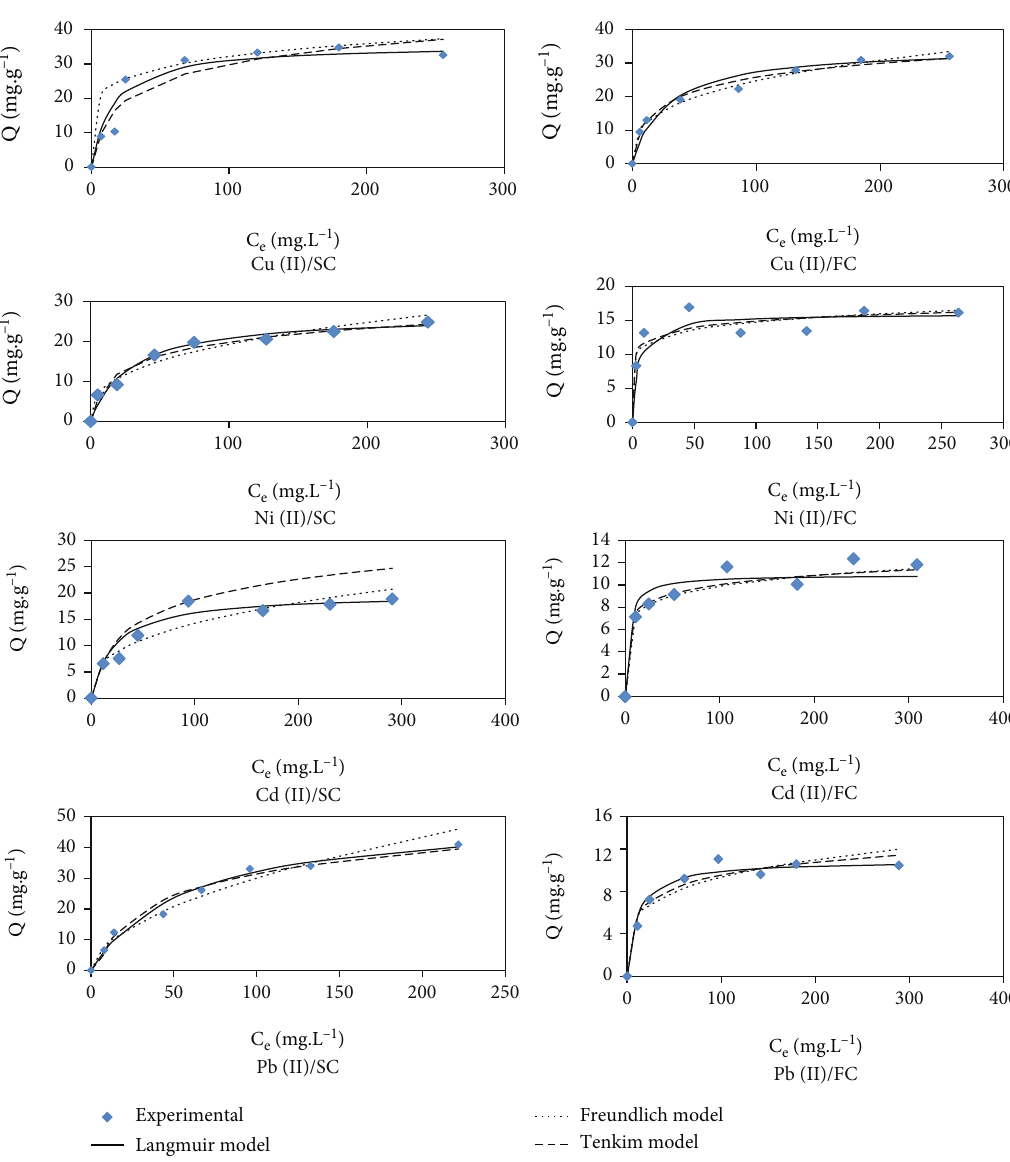
Figure 4: Experimental results of the adsorption equilibrium of Cu(II), Ni(II), Cd(II), and Pb(II) in SC and FC clays and theoretical curves from Langmuir, Freundlich, and Tenkim models at pH5.5, T = 28 ° C , and stirring speed of 150